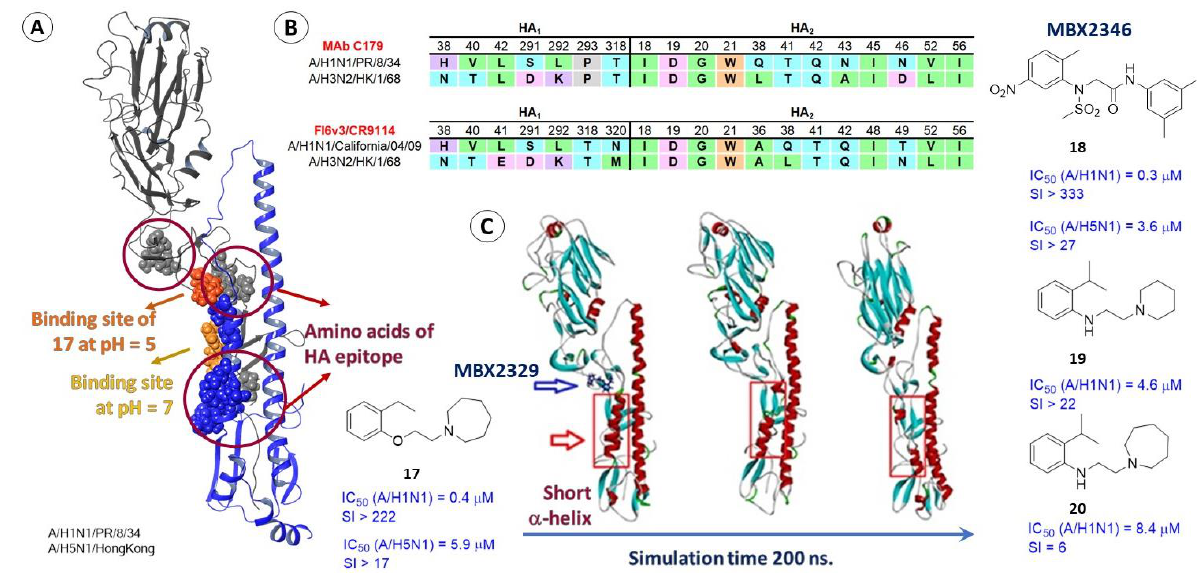
Figure 7. Epitopes of HA as a possible binding site for HA inhibitors. The binding site of MBX2329 ( A ): the yellow and orange spheres show the location of the compound at different pH values of the medium and the amino acids of the HA epitope are shown in gray (correspond to HA 1 ) and blue (correspond to HA 2 ) spheres. The table ( B ) shows the contact between amino acids of HA and residues of antibodies MAb C179, CR9114, and FI6v3 form significant intermolecular interactions. The figure from the original paper [37] ( C ), where a noticeable effect of MBX2329 on the secondary structure of HA ( especially on the short protomer α -helix) is visualized during 200 ns of molecular dynamic simulations.